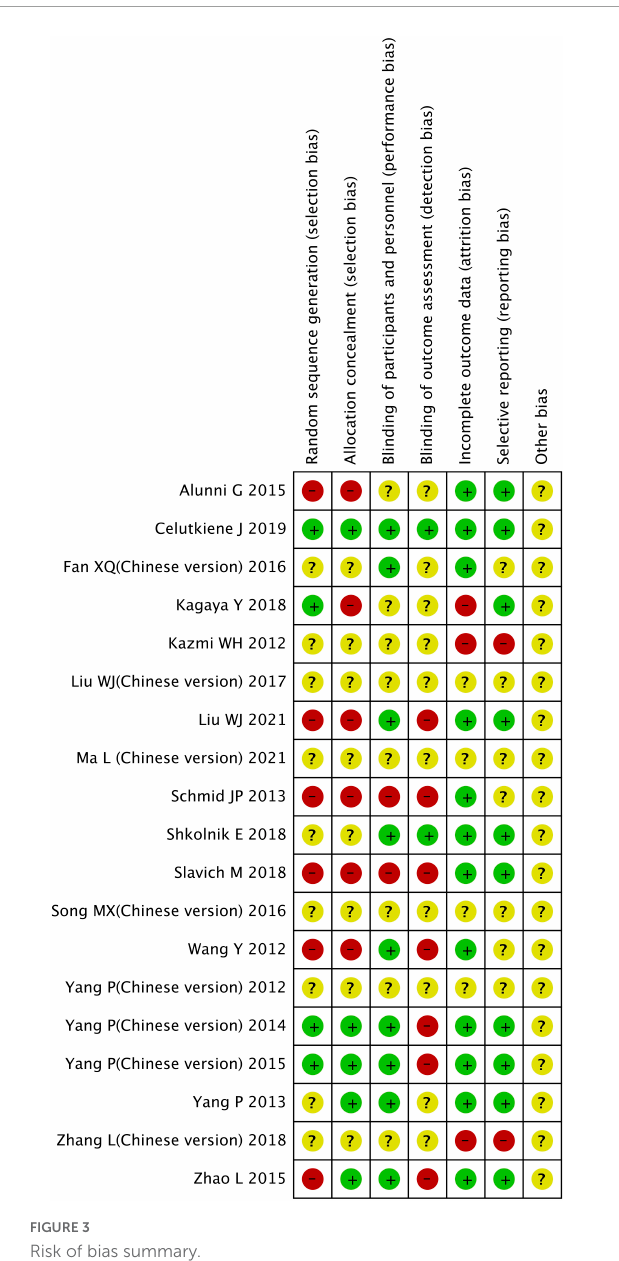
FIGURE3 Risk of bias